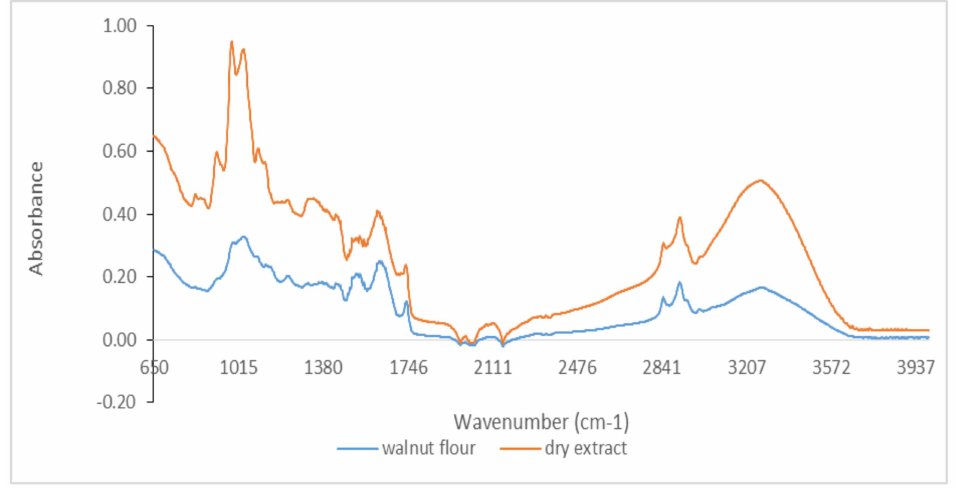
Figure 4. FTIR spectra for walnut flour and its dry extract in the region between 650 and 4000 cm − 1